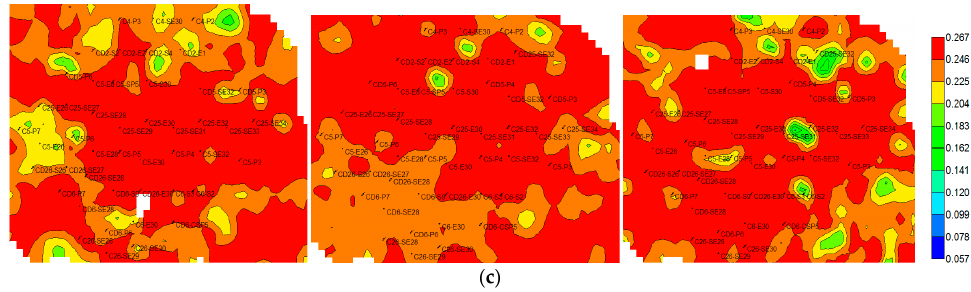
Figure 2. Contour map of main layer. ( a ) Permeability contour map; ( b ) porosity contour map; and ( c ) oil saturation contour map.